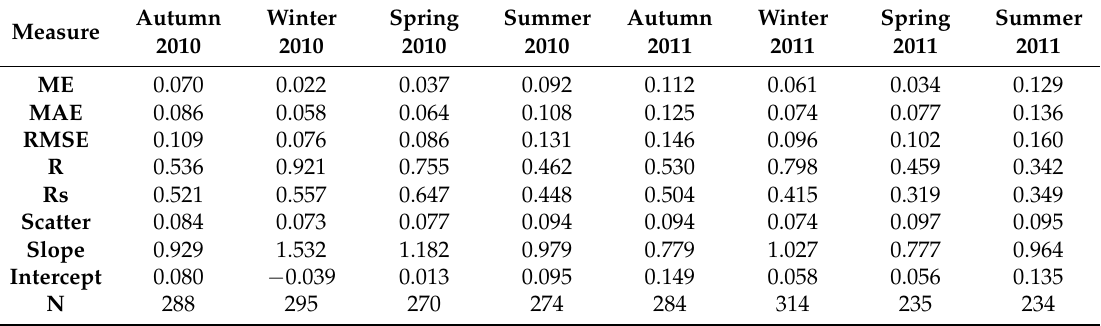
Table 7. Comparison per season between Satellite (ASCAT 25Km) and observed SSM at all validation sites in AUSTRALIA for 2010, 2011, and both